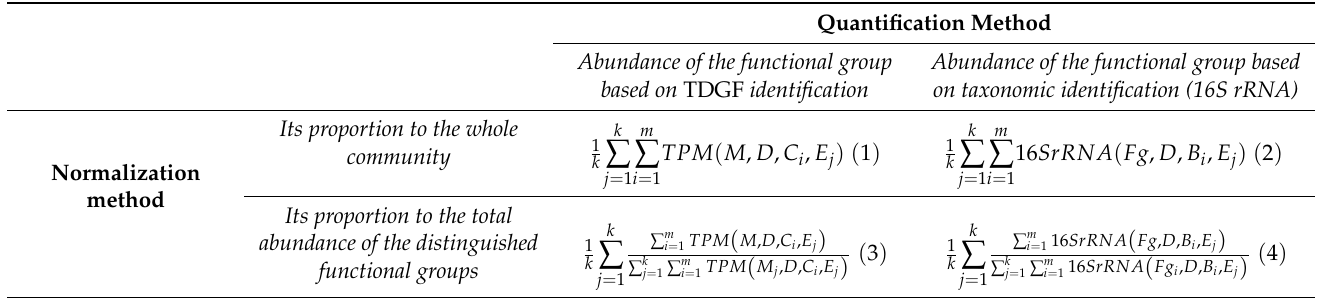
Table 1. Formulae for assessing the abundance of functional groups classified according to used quantification and normalization methods. Fg is the analyzed functional group, M is the TDGF selected for analysis, B is the bacteria that belong to the analyzed functional group, C is the isoform of the transcript to which TDGF aligned, D is the diet, E is the mouse (separate experiment). Quantification Method Abundance of the functional group Abundance of the functional group based based on TDGF identification on taxonomic identification (16S rRNA)